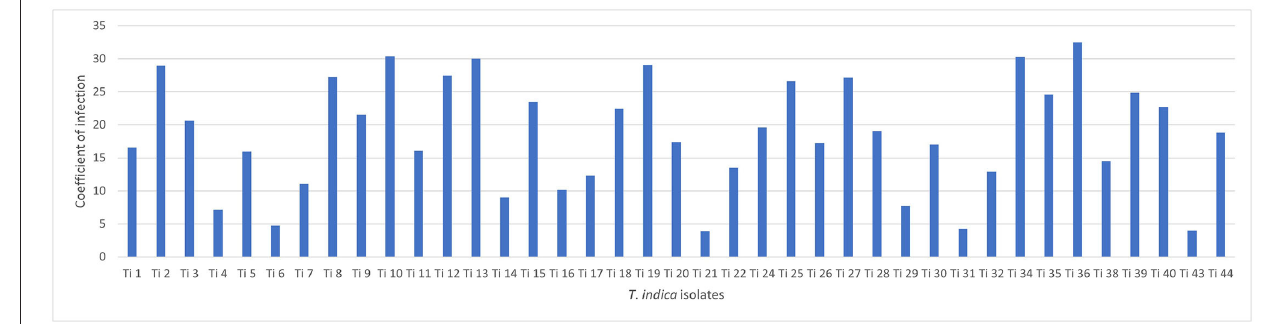
FIGURE 1 | Virulence analysis of Tilletia indica isolates.